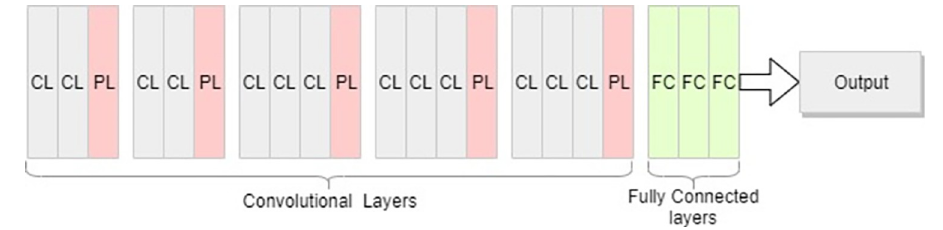
Fig 2. Generic VGG16 model.